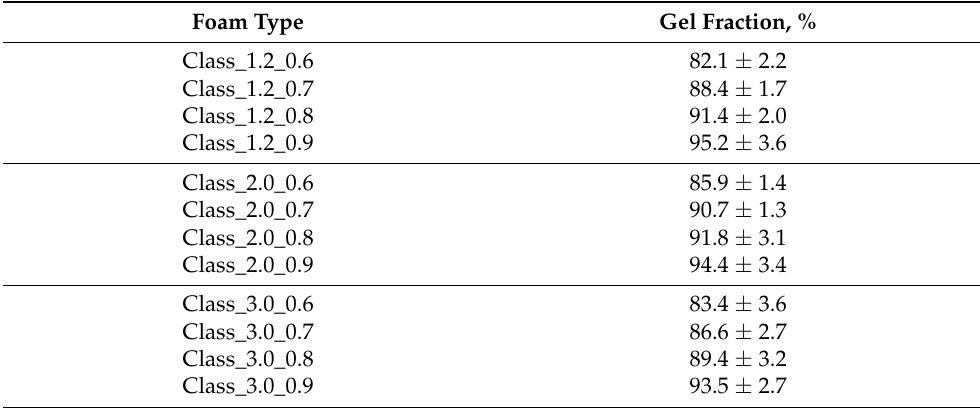
Table 3. Gel fraction of foam samples depending on I NCO and water